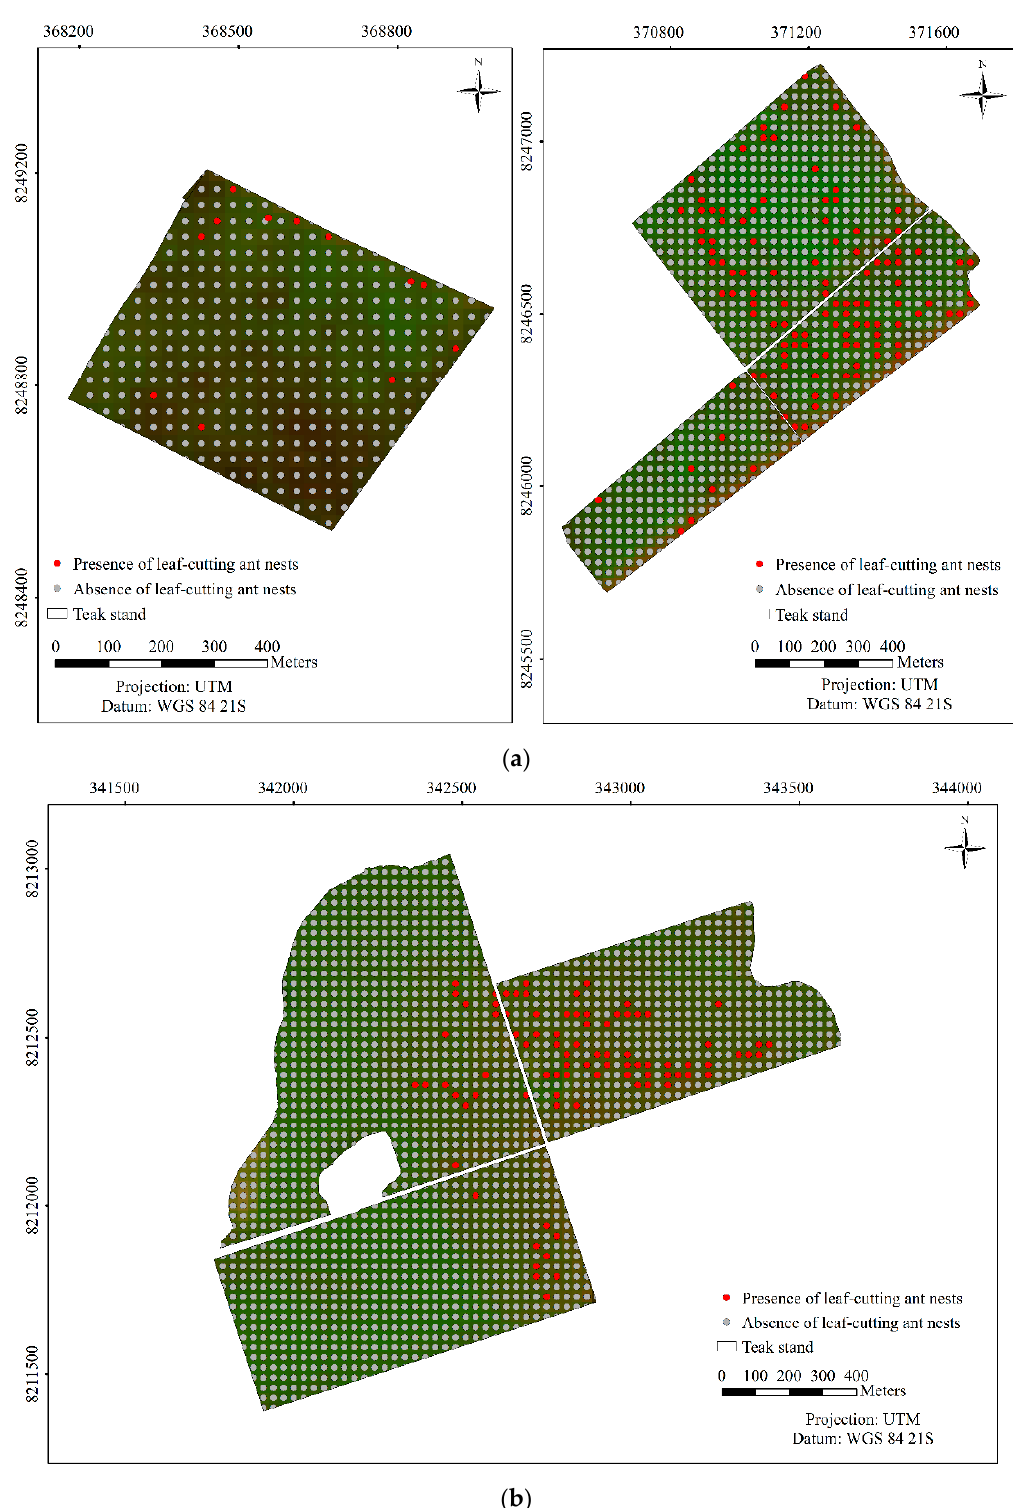
Figure 3. Prediction maps of the presence and absence of leaf-cutting ant nests in Tectona grandis stands in areas 1 ( a ) and 2 ( b ) (false color composition).